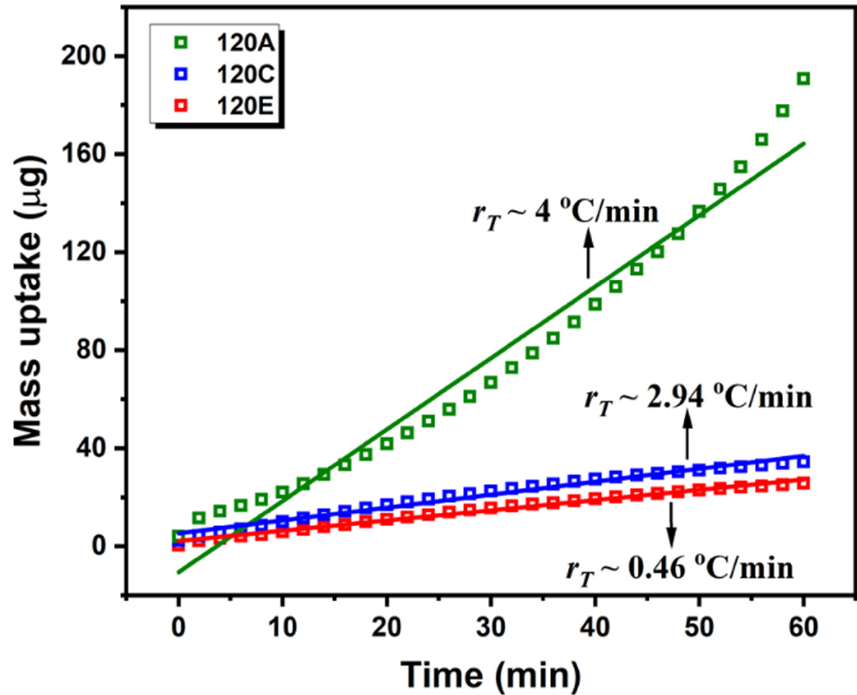
Figure 5. Evolution of mass uptake with respect to time for PS- b -PLA films exposed to THF solvent at different heating ramps in the oven. Linearly proportional mass uptake with time affirms Case II diffusion.